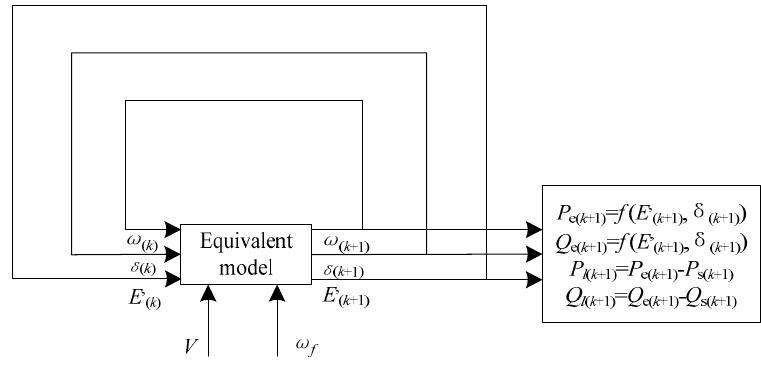
Figure 3. The schematic diagram of power in tie line.